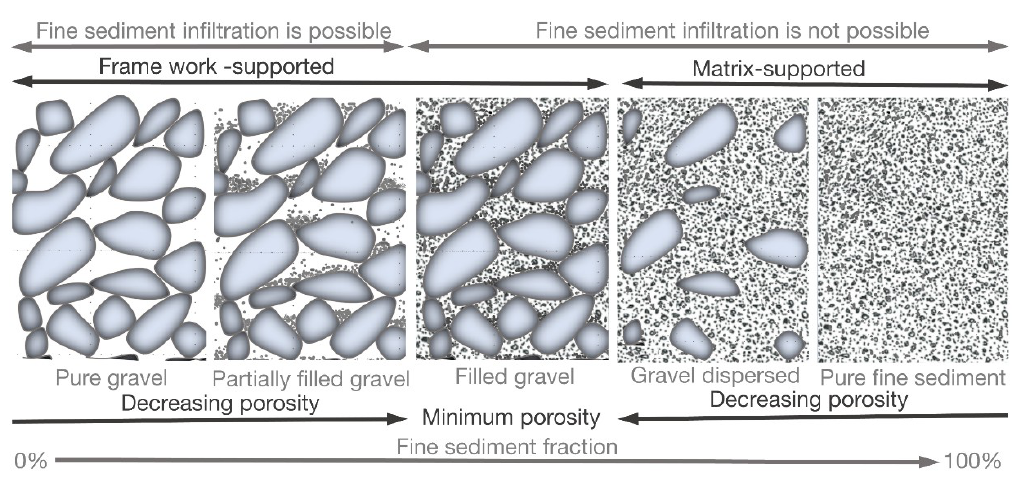
Figure 4. Schematic structure of bottom sediments as a function dependent on the magnitude of the fine component sediment.